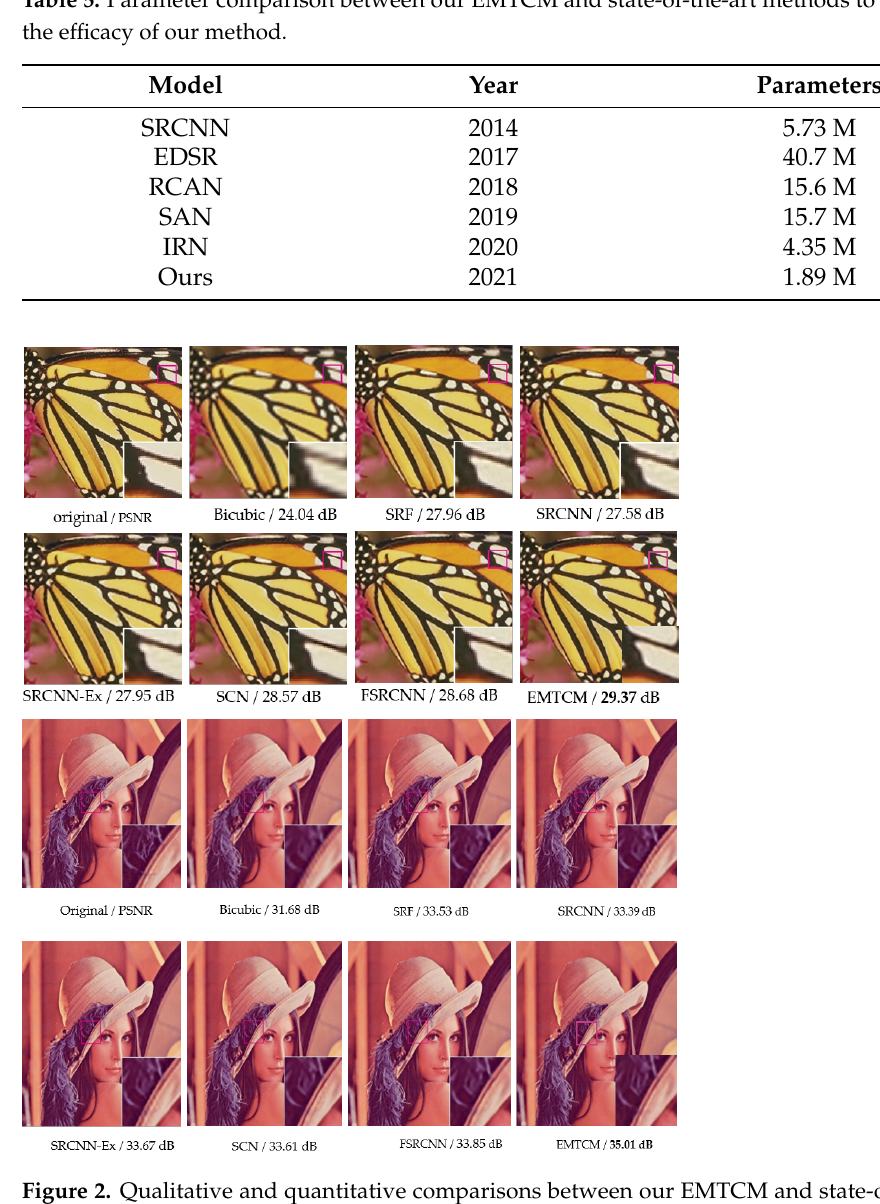
Figure 2. Qualitative and quantitative comparisons between our EMTCM and state-of-the-art SR models with the scale factor 3. Best viewed zoomed